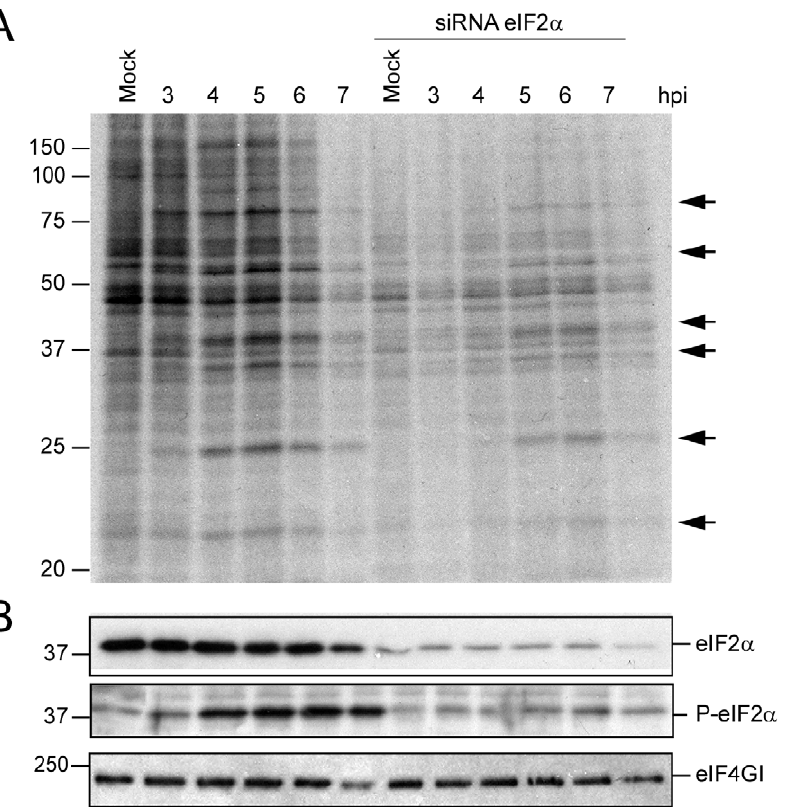
Figure 4. EMCV infection of Hela cells depleted or not of eIF2 a . A) Hela cells transfected with a mixture of siRNAs targeting eIF2 a mRNA or mock Hela cells were infected with EMCV (10 pfu/cell) at 36 h post-transfection. Next, protein synthesis was determined by [ 35 S]Met-Cys labelling at the hpi indicated. Samples were analyzed by SDS-PAGE, fluorography and autoradiography. B) Western blot analysis of samples from panel A using anti-eIF2 a or anti-phospho-eIF2 a antibodies. As a control, the amount of eIF4GI in each sample was determined using specific antibodies against this factor. The arrows indicate viral proteins.